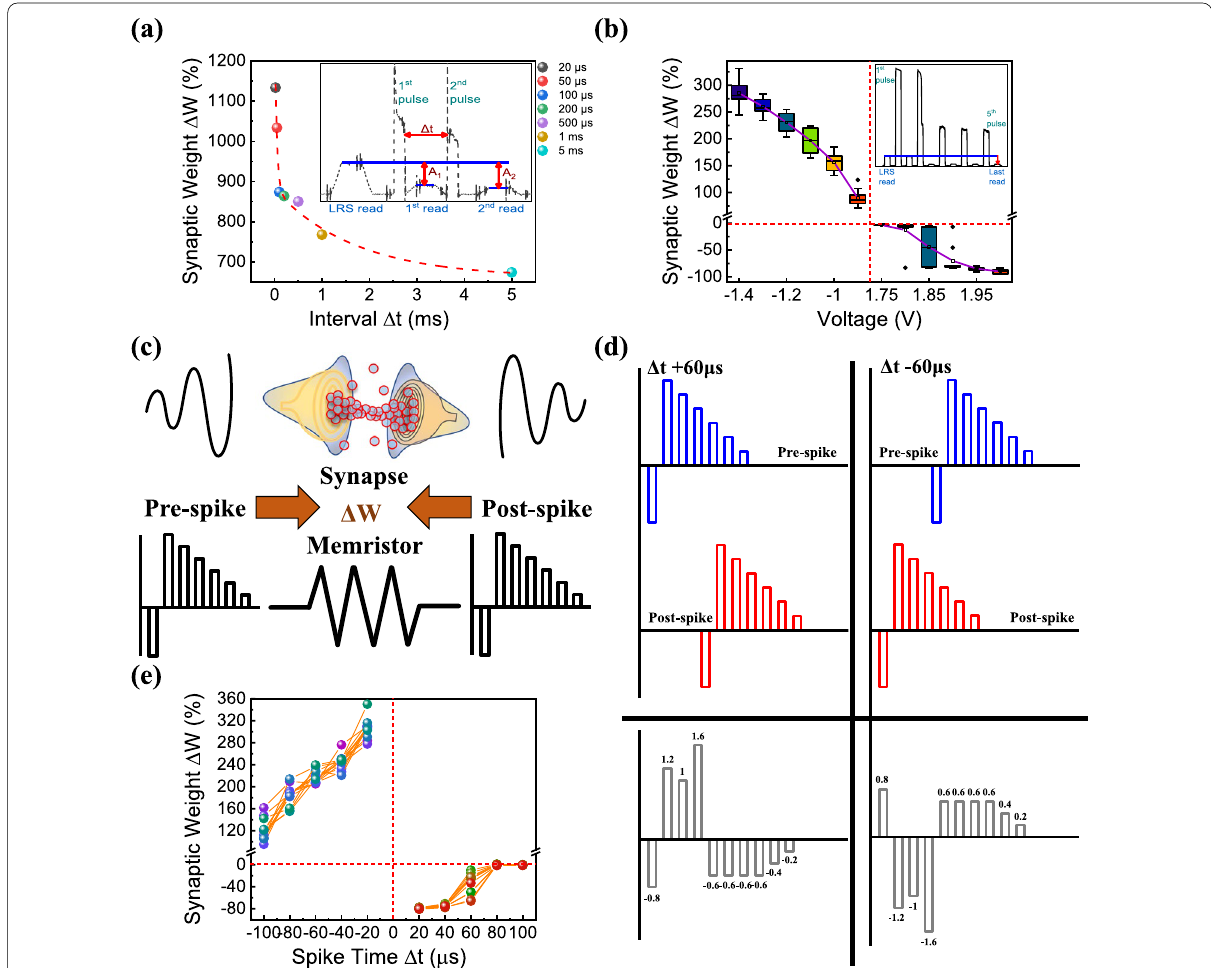
Fig. 7 a PPD measurement, b EPSC data according to amplitude. STDP characteristics: c Schematic for measurement imitation between synaptic neural structure and RRAM, d pulse authorization for STDP measurement at Δ t